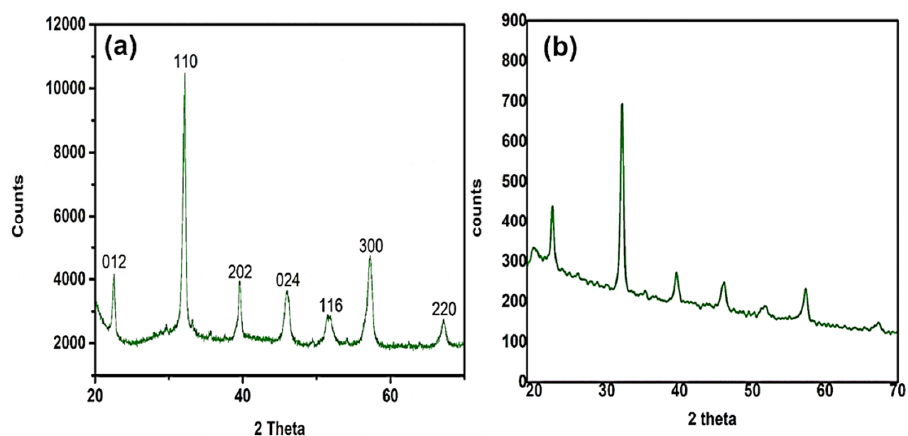
Figure 7. ( a ) XRD pattern of synthesized BFO and ( b ) XRD pattern of synthesized CBB.